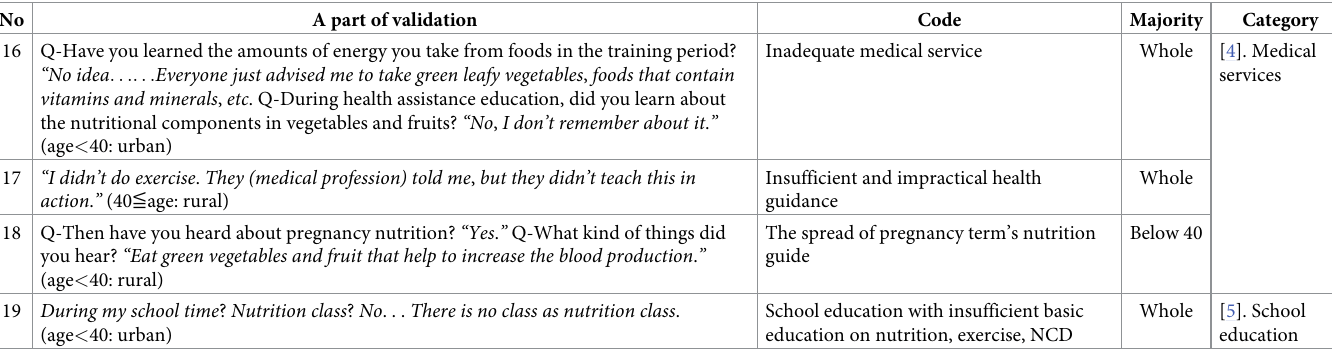
Table 6. Theme III: Current situation of health education: Validation , code , categories and themes .